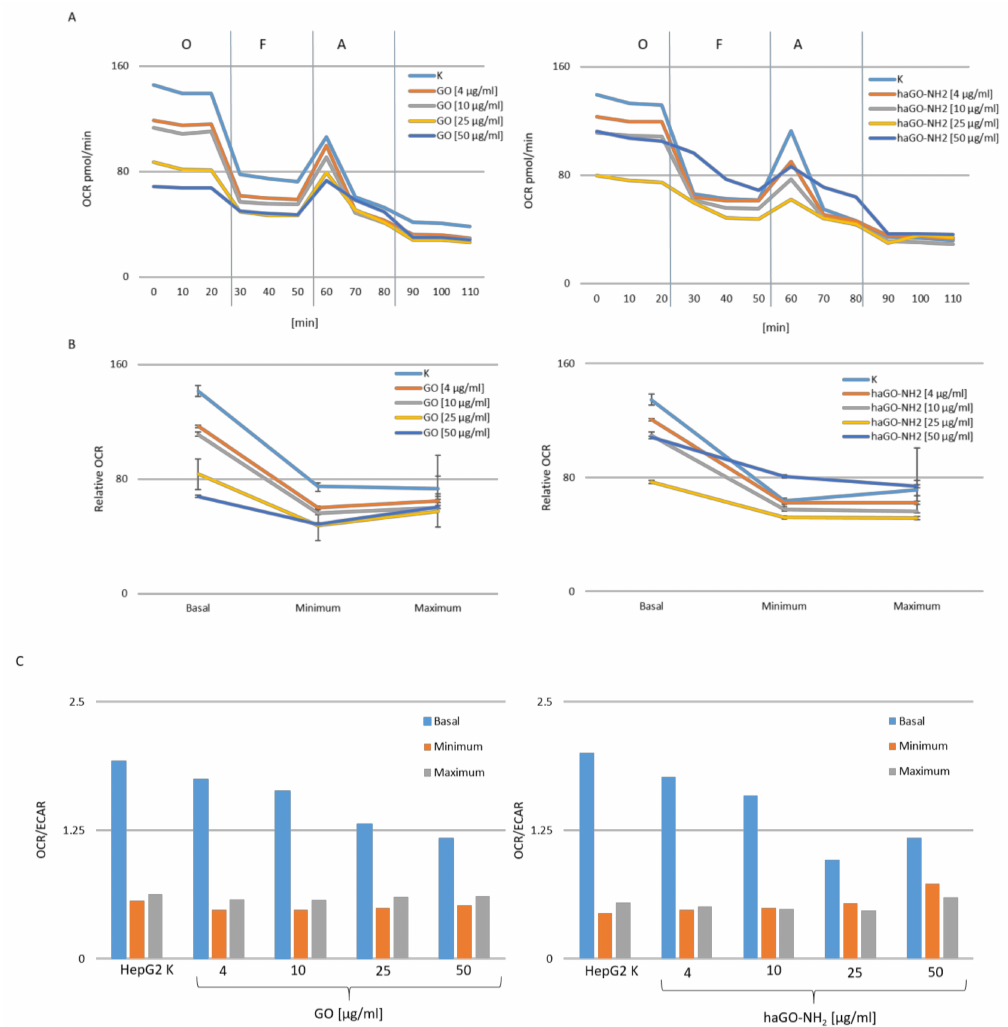
Figure 6. Metabolic studies of HepG2 cells treated with GO and haGO-NH 2 NPs by Seahorse analyses. ( A ) Mitochondrial oxygen consumption rate (OCR) of HepG2 cells treated with pristine and aminated GO NPs for 24 h in real time under basal conditions and in response to mitochondrial inhibitors (O, oligomycin; F, FCCP; A, antimycin). ( B ) Mitochondrial parameters of cells treated for 24 h with GO and haGO-NH 2 . ( C ) Representation of the ratio between the basal OCR and ECAR where the OCR was measured at the same time as ECAR for HepG2 cells after treatment with both types of